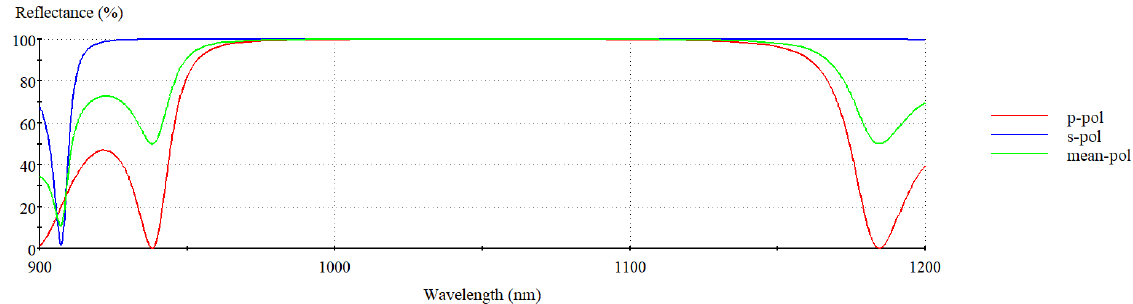
Figure 4. The reflectance of a dielectric multilayer was simulated using the Essential Macleod.